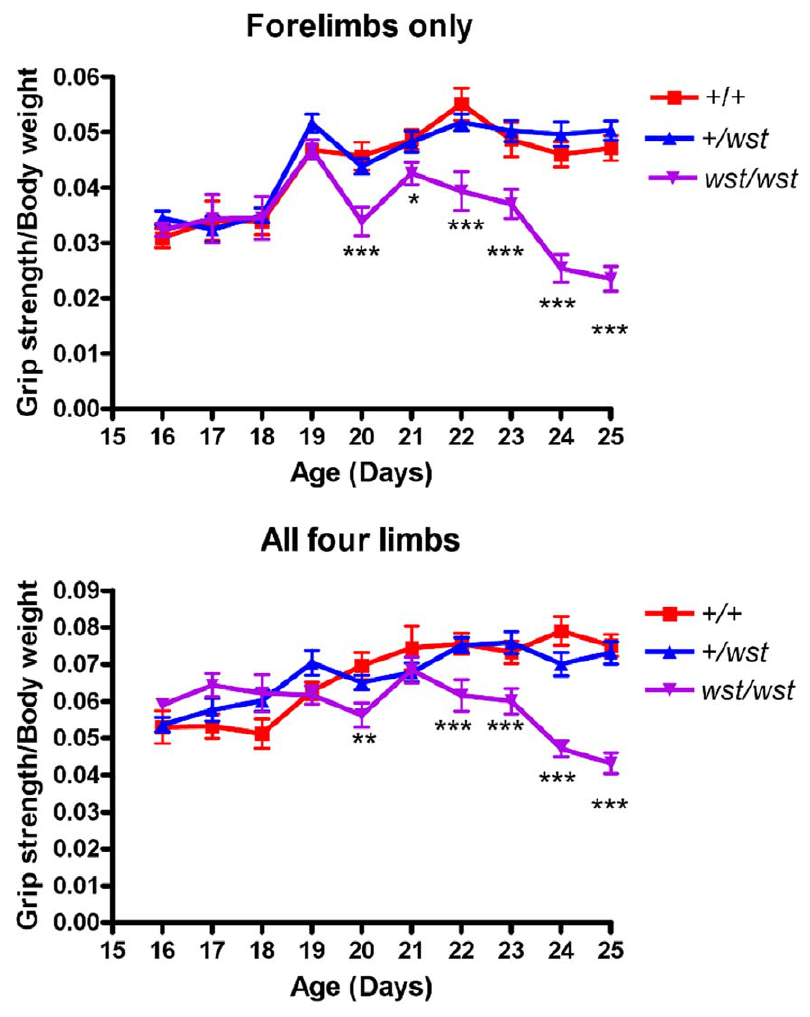
Figure 2. Grip strength analysis of young wasted mice. Forelimb (top panel) and all four limbs (bottom panel) grip strength analysis of wasted mice. The daily grip strength reading of 3 tests (measured in Newtons) were normalised to body weight (measured in grams). P values were calculated comparing wasted mice with controls ( + / + and + /wst combined). * indicates a P value , 0.05, ** indicates a P value , 0.01, and *** indicates a P value , 0.001.